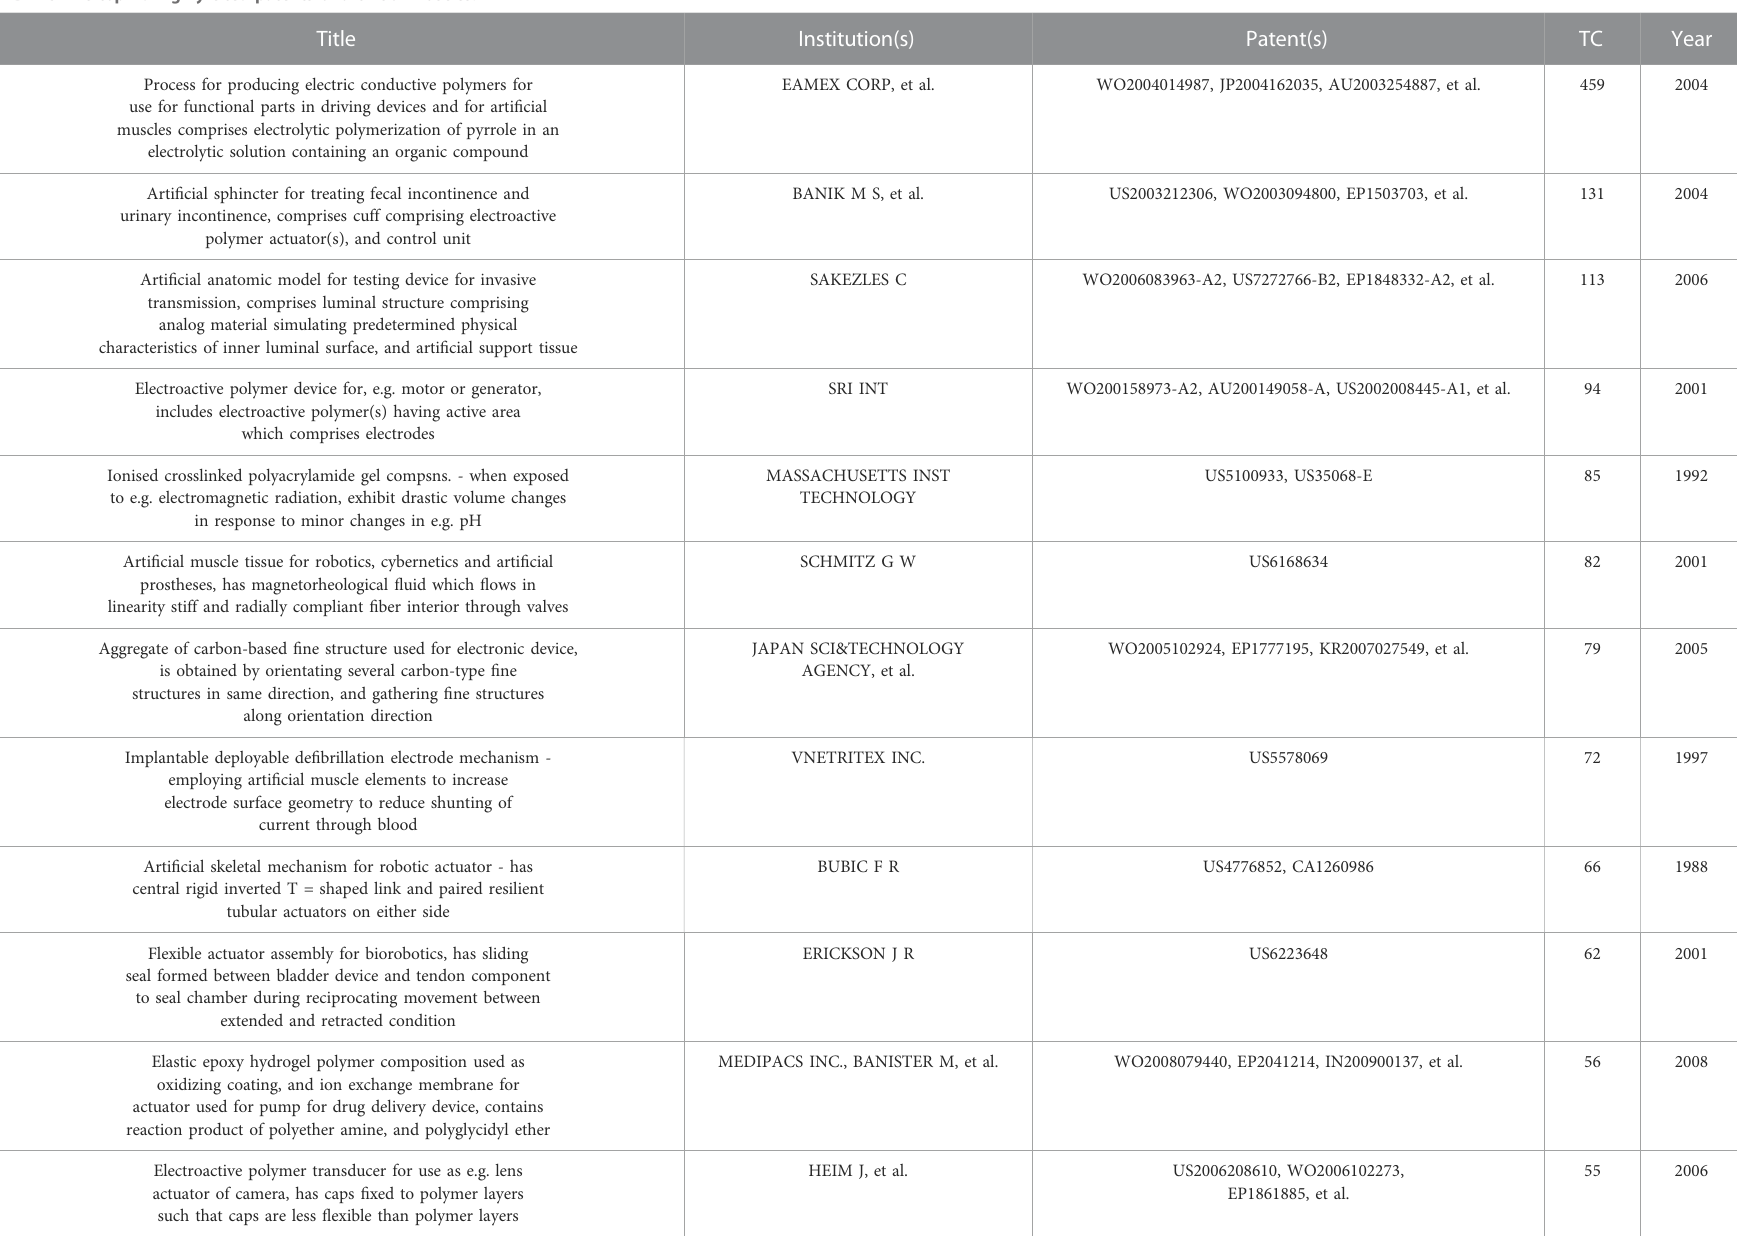
TABLE 5 The top 20 highly cited patents of arti fi cial muscles.